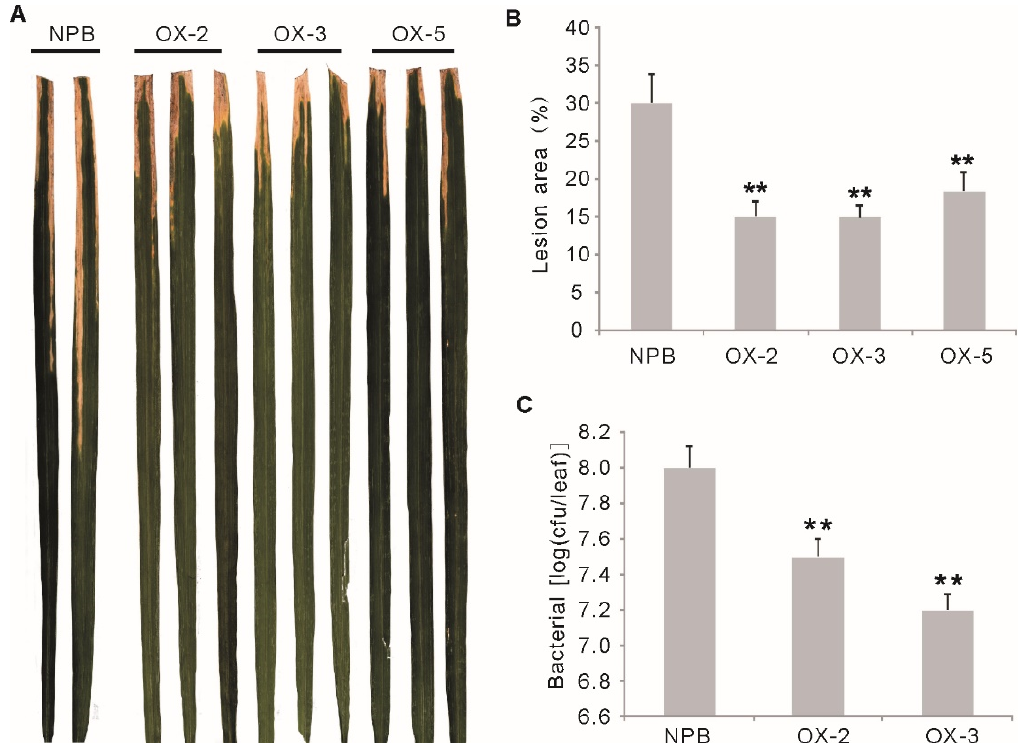
Figure 3. Disease phenotypes of the OXGF14f plants after bacterial blight infection. ( A ) Disease phenotypes of the OXGF14f plants and Nipponbare plants after Xoo inoculation. ( B ) Relative lesion area in the OXGF14f plants and control plants after Xoo inoculation. Error bars indicate the SD from at least ten biological replicates. ** p < 0.01. ( C ) The growth of the bacterial from Xoo race 4 in leaves of the OXGF14f plants and Nipponbare plants. Bacterial populations were determined from three leaves at 14 days after inoculation by counting colony-forming units (cfu). Similar results were obtained in two independent biological experiments. Error bars indicate the SD from six biological replicates. ** p < 0.01.